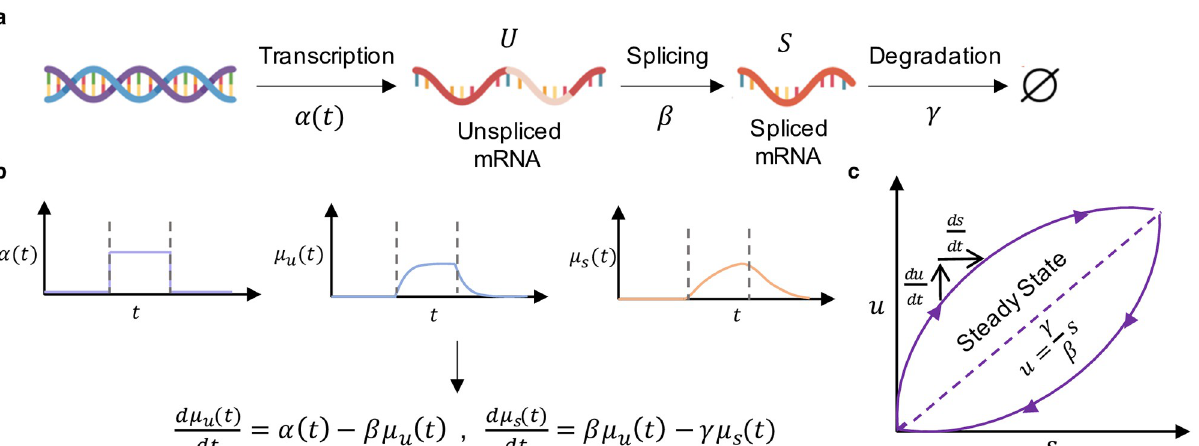
PLOS Computational Biology | https://doi.org/10.1371/journal.pcbi.1010492 September 12,